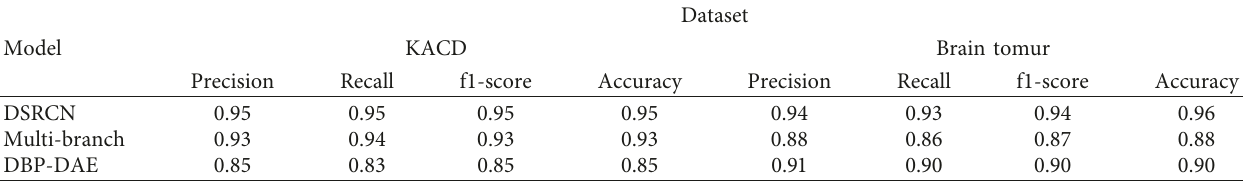
Figure 8: Comparison of ROC curve for proposed approaches. (a) Brain Tumor dataset. (b) KACD dataset. Table 4: Accuracy results of proposed approaches based on KACD and brain tumor.